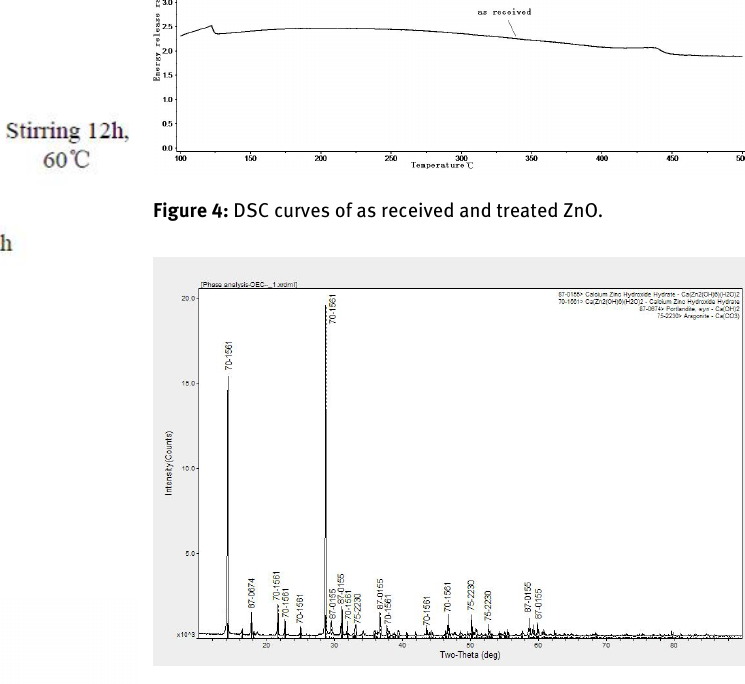
Figure 5: XRD diffractogram of prepared CaZn(OH) 4 ; peak indication: 87-0155 Ca(Zn 2 (OH) 6 (H 2 O)) 2 , 70-1561 Ca(Zn 2 (OH) 6 (H 2 O)) 2 , 87-0674 Ca(OH) 2 , 75-2230 Ca(CO) 3 .